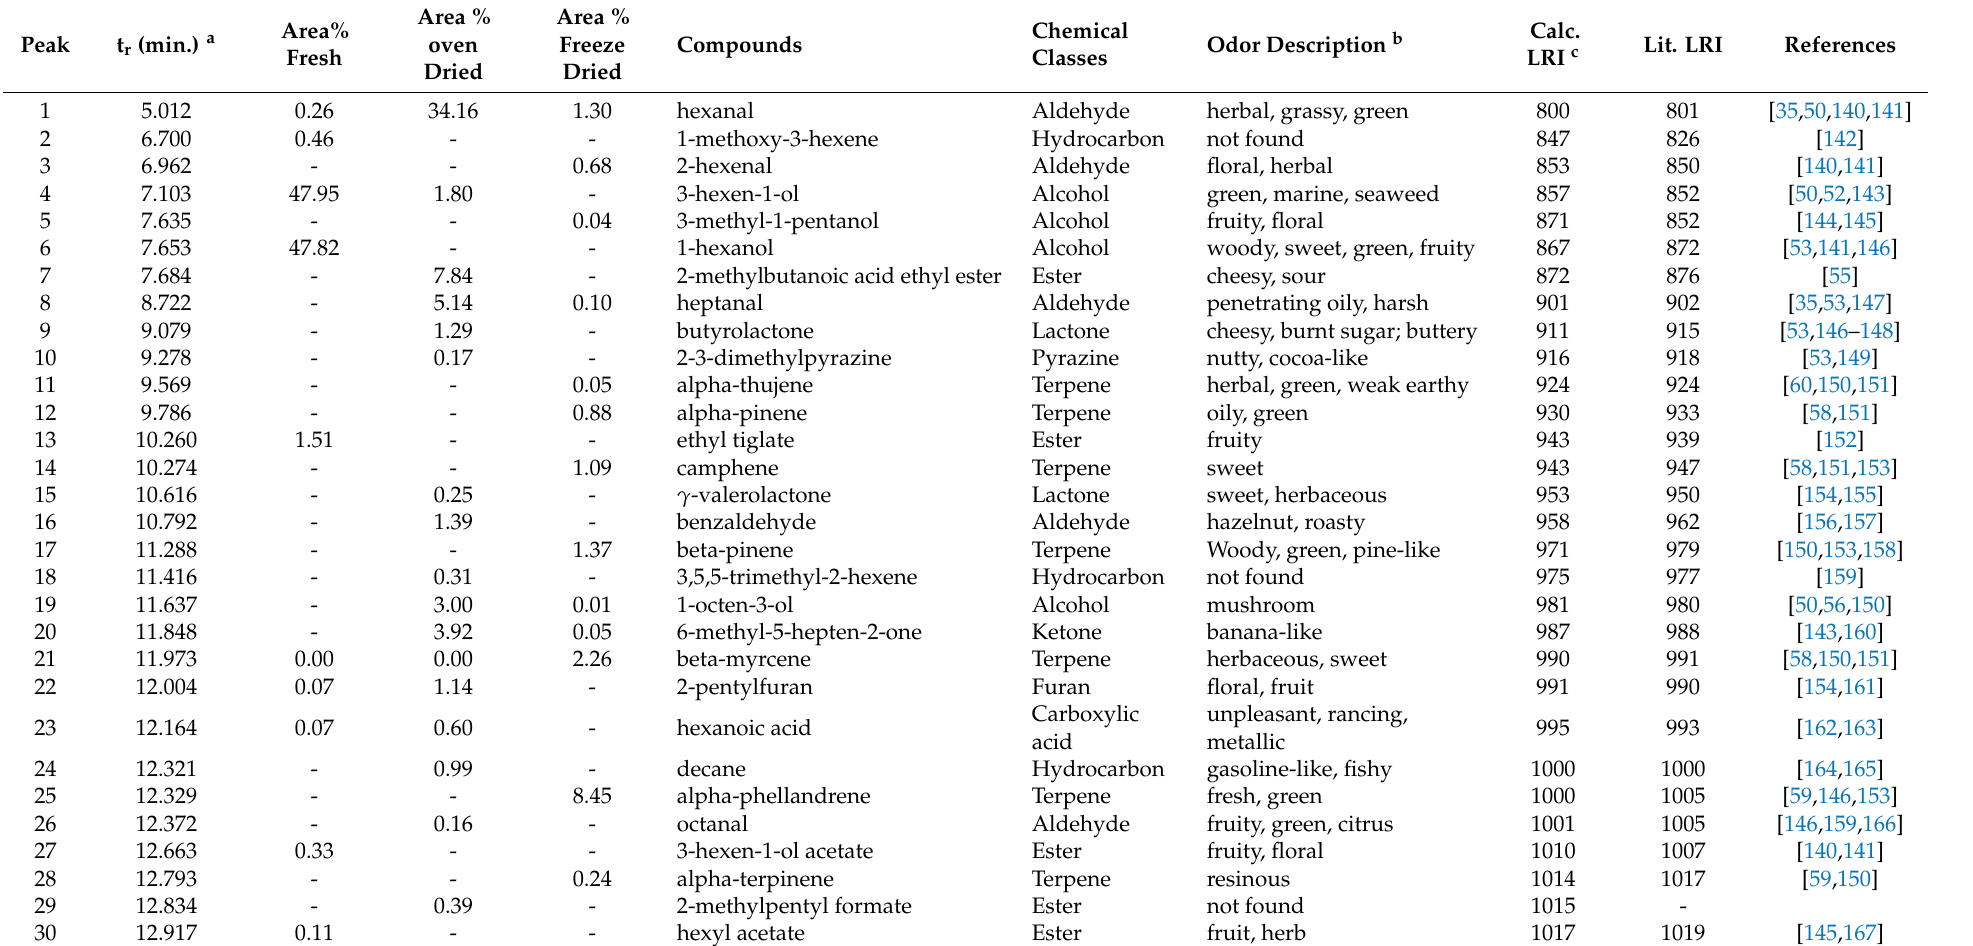
Table A1. Characterization parameters (retention time (tr), % of total peak area, identification, chemical classes, odor, calculated retention index) of volatile compounds identified in fresh, oven dried and freeze dried S. ramosissima using SPME-GC–MS and the bibliographic references to support the